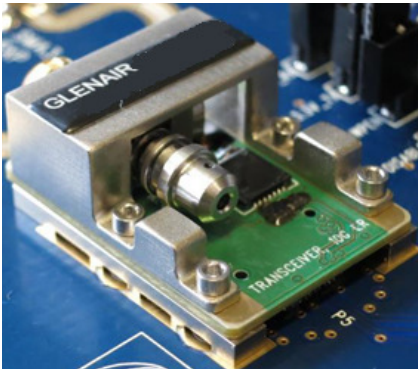
Figure 3. The new Glenair transceiver for the